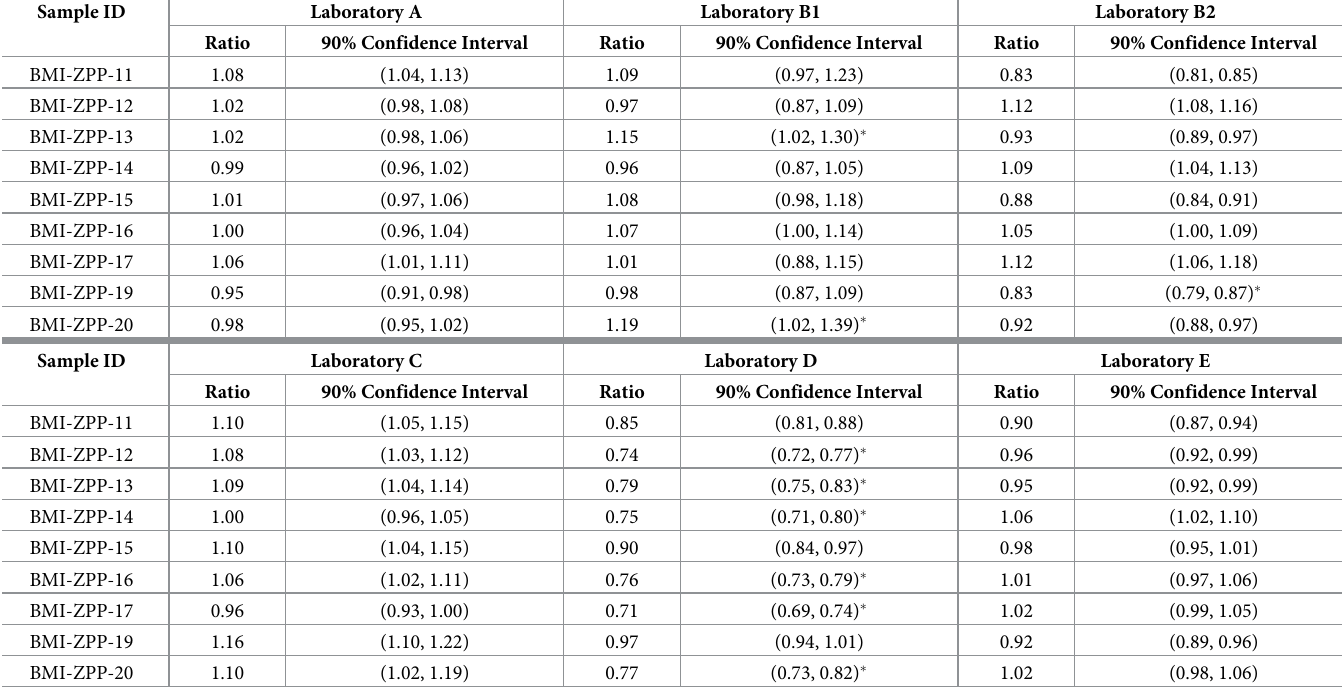
Table 7. Ratio of laboratory mean concentration to overall consensus value with 90% confidence intervals for each test